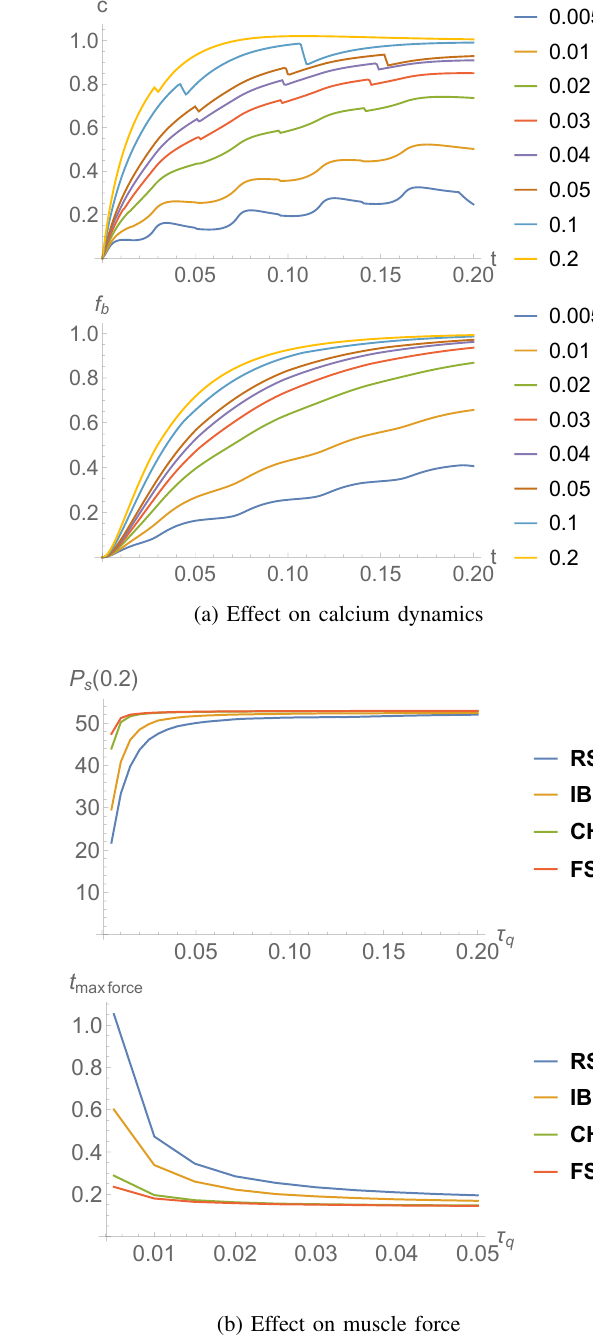
Fig. 6: Effect of varying the parameter τ q